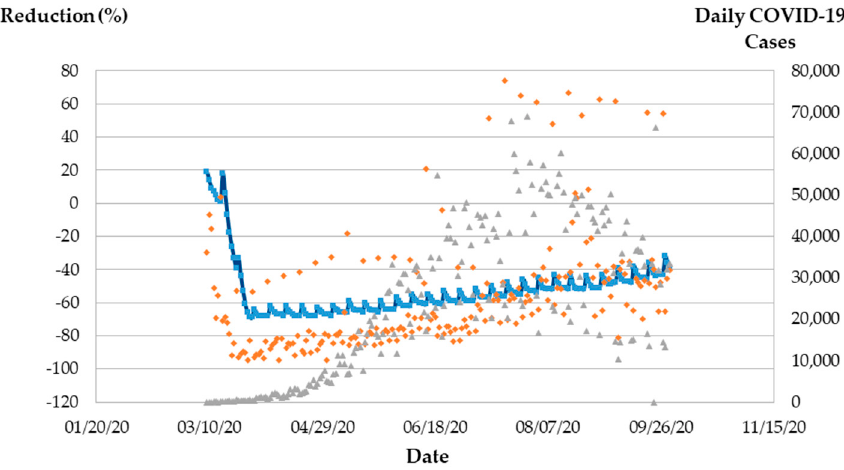
Figure 7. Percentage reduction (%) in traffic congestion (red) and urban transport use (blue), com- pared to the number of daily COVID-19 infections (gray). Brasilia, Brazil.